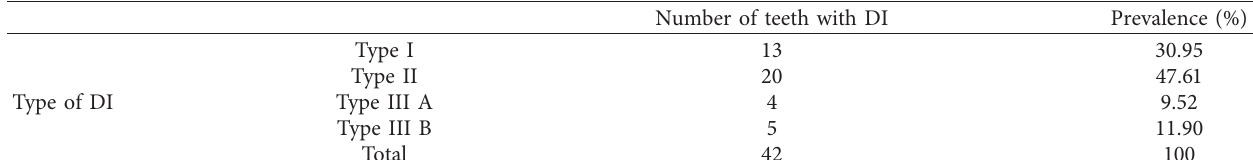
Table 2: Distribution of the type of dens invaginatus (DI) in anterior maxillary teeth.